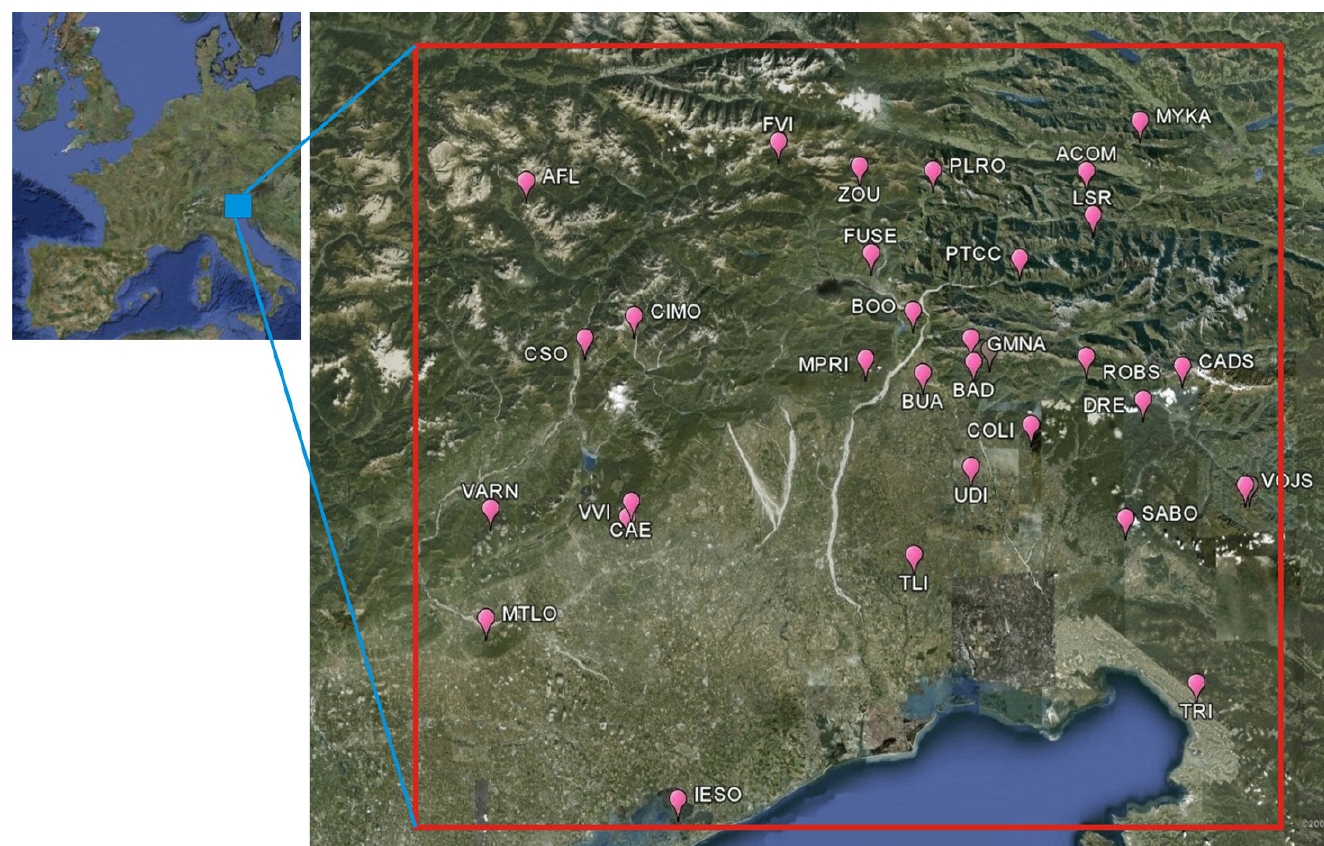
Figure 5. Map of the OGS seismological network in north-eastern Italy. Red rectangle, modeled area in Figures 1 and 2.